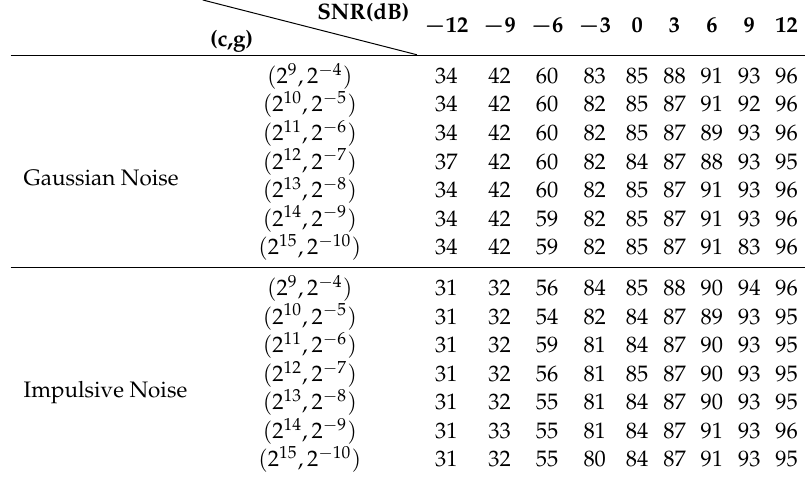
Table 5. Leakage signal identification rate in an environment containing Gaussian noise and impulse noise.